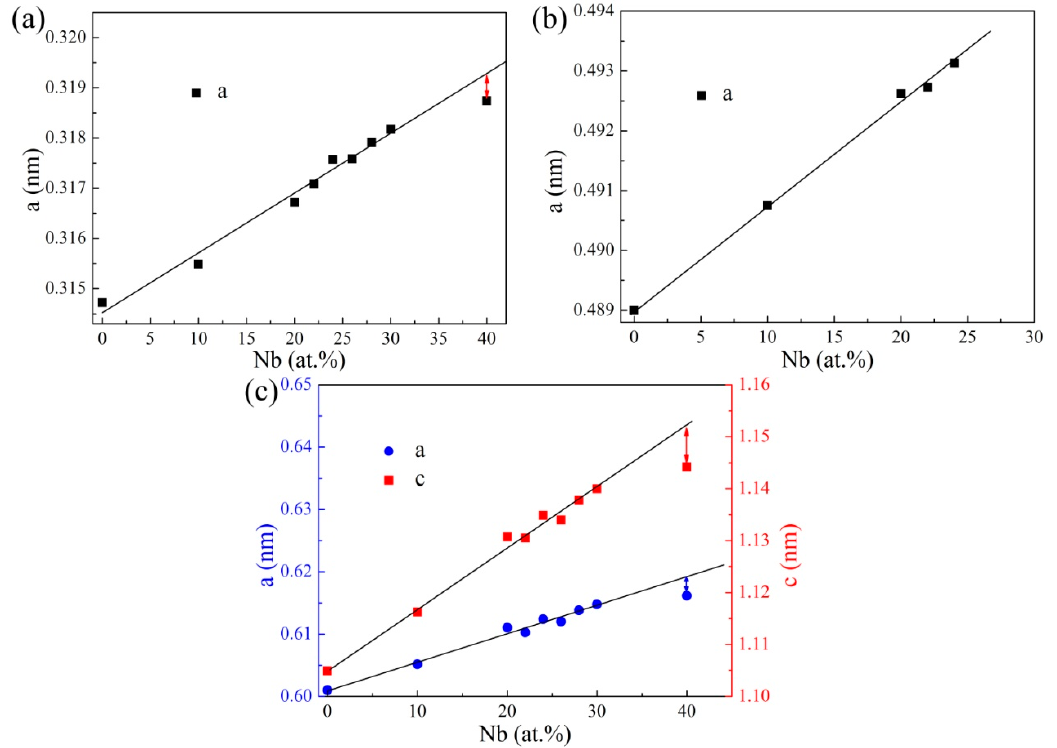
Figure 7. Lattice constants of ( a ) Moss, ( b ) Mo 3 Si, and ( c ) Mo 5 SiB 2 vs. Nb contents. Table 2. EDS-analyzed compositions of the different phases in samples S-24Nb/30h and S-26Nb/30h indicated by arrows in Figure 8. Composition (at.%) Sample Phase